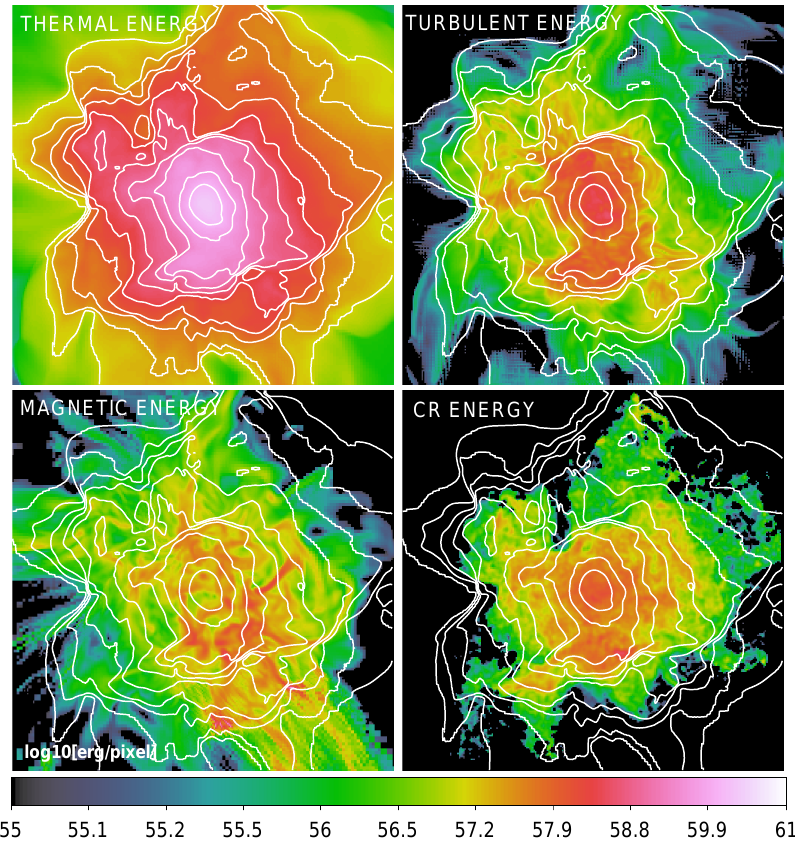
Figure 1. Projected energy maps for our simulated clusters at z = 0, including the thermal energy ( top left ) the turbulent energy ( top right ); the magnetic energy ( lower left ) and the CR-proton energy ( lower right ). The size of each image is 8.192 Mpc. For clarity the white contours of the projected thermal energy are reported in each